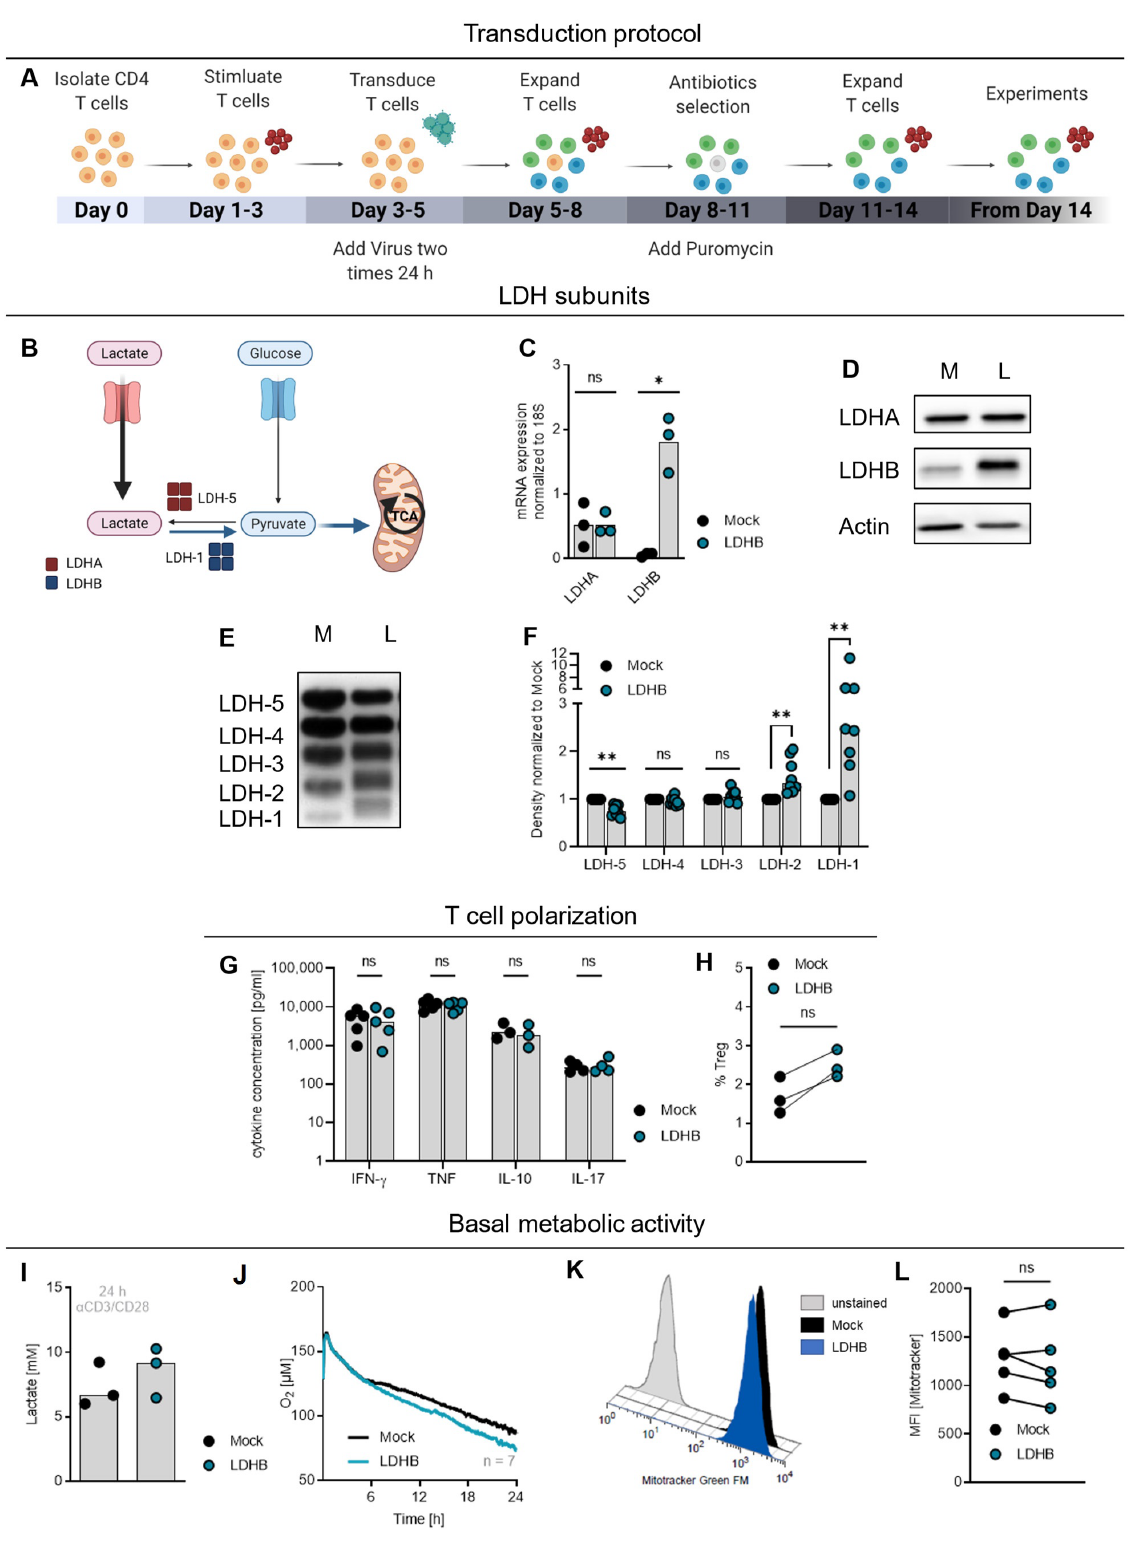
Figure 2. LDHB overexpression in human CD4 T cells does not alter cytokine profile or lactate secretion, but slightly increases cellular respiration. ( A ) Schematic overview over the retroviral transduction process to overexpress LDHB. Red dots represent Dynabeads. Graphic created with BioRender.com. ( B ) Schematic depiction of the impact of LDHB overexpression in lactic acid treated T cells. Graphic created with BioRender.com. ( C – K ) LDHB was overexpressed in human CD4 T